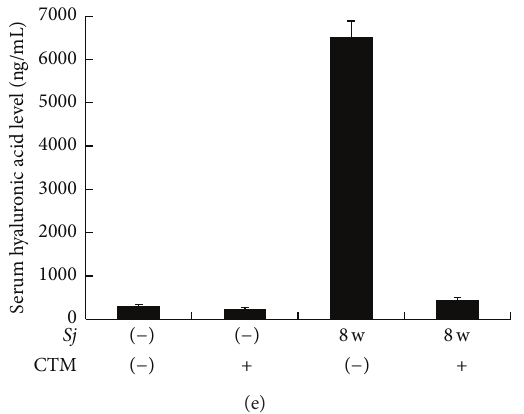
Figure 4: Cystamine as an inhibitor of tTG alleviated the extent of liver fibrosis. tTG activity in BALB/c mice is blocked by CTM intraperitoneal injection from day 3 to day 10 after Sj infection. Mice are sacrificed at week 8 after infection. Liver tissues are fixed and stained with anti-tTG (a), anti- 𝛼 -SMA antibody (b) (original magnification 40x), or Masson trichrome (d) (magnification 20x). Noninfected mice with or without CTM treatment acted as controls. Collagen deposition area percentage (Masson trichrome staining positive area percentage of each section) is calculated and shown in (d). Level of 𝛼 -SMA protein expression in mouse liver tissues is shown through Western blot analysis, and GAPDH is detected as an internal control (c). Concentration of hyaluronic acid in mouse liver serum is shown in (e) through ELISA assay. Data are presented as mean ± SD from eight mice per group. ∗∗ 𝑃 < 0.01